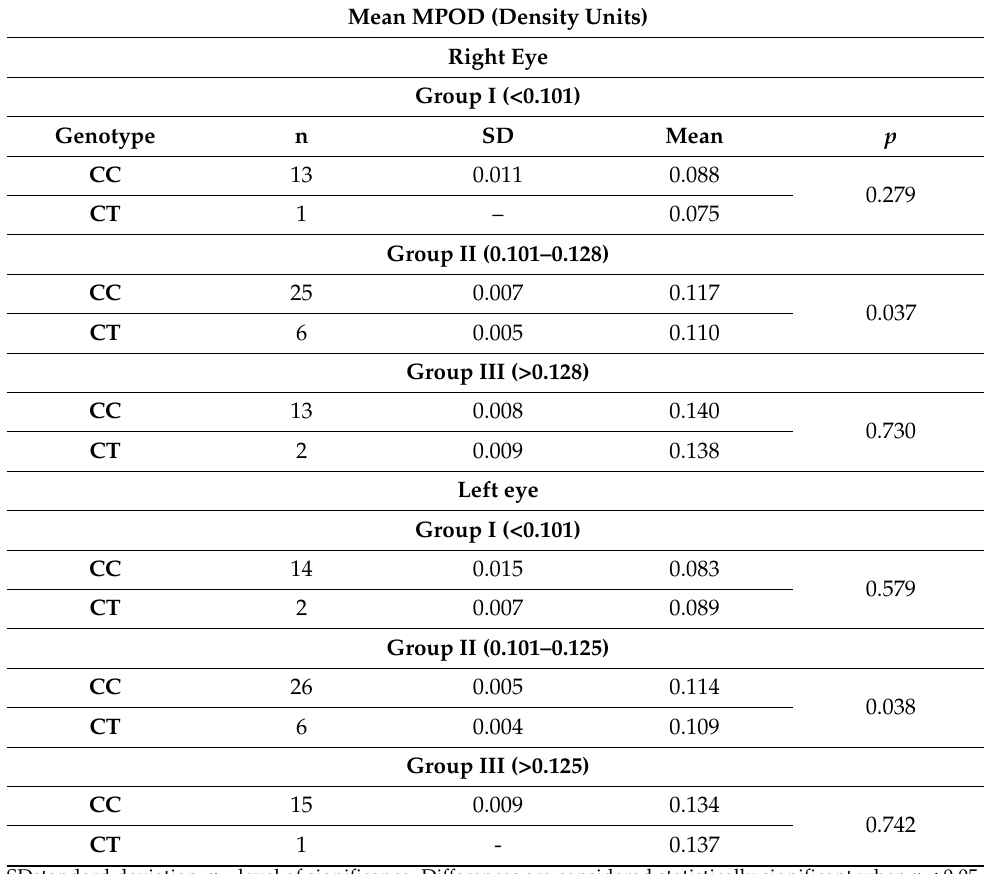
Table 6. Comparison of mean optical density and SCARB1 SNP rs11057841 genotypes in the AMD group. Mean MPOD (Density Units) Right Eye Group I (<0.101) Genotype n SD Mean p CC